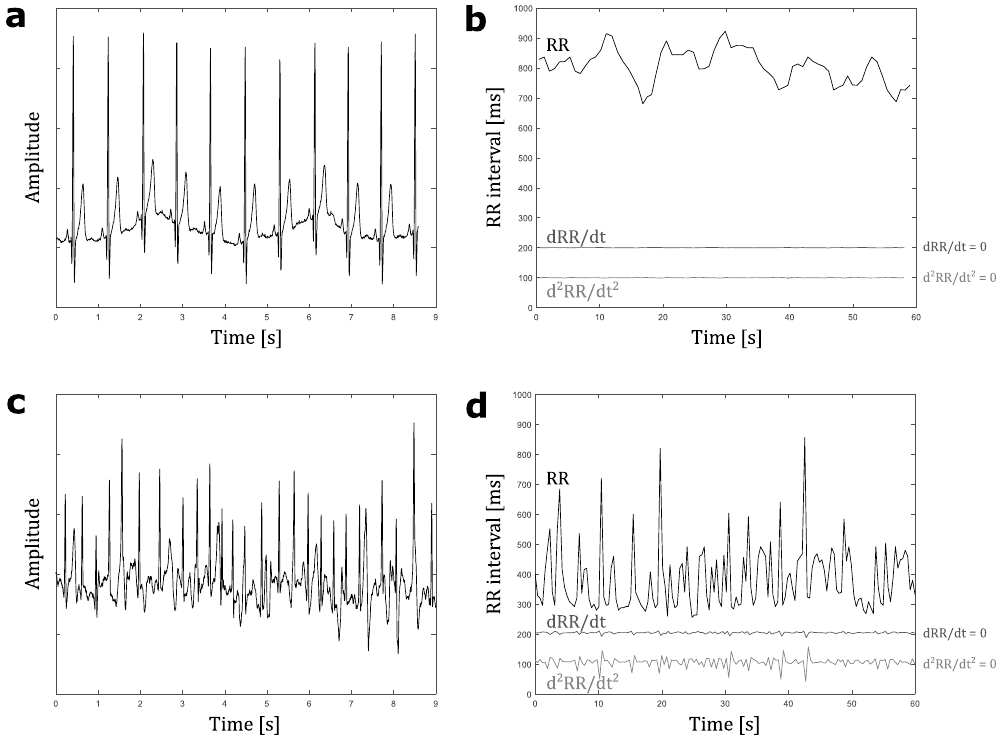
Figure 3. Illustrative example of ECG recording and time series generation. ( a ) Short fraction of ECG recording n° 16773 extracted from PhysioNet MIT-BIH nsrdb from t = 0 s to t = 9 s, showing a normal sinus rhythm. ( b ) One-minute RR interval time series (black tachograms) generated after R peak detection with a homemade algorithm of n° 16773 ECG recording ( a ) from t = 0 s to t = 60 s. Induced time series dRR/dt and d 2 RR/dt 2 (first and second time derivatives time series computed from the initially generated RR interval time series) are also plotted in dark and light grey, respectively. ( c ) Short fraction of ECG recording n° 04126 extracted from PhysioNet MIT-BIH afdb from t = 97 s to t = 106 s, showing an atrial fibrillation. ( d ) One-minute RR interval time series (black tachograms) generated after R peak detection with a homemade algorithm of n° 04126 ECG recording ( c ) from t = 97 s to t = 157 s. Induced time series dRR/dt and d 2 RR/dt 2 (first and second time derivatives time series computed from the initially generated RR interval time series) are also plotted in dark and light grey,